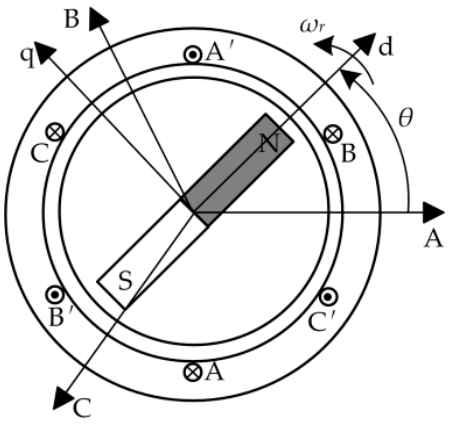
Figure 1. Schematic diagram of permanent magnet synchronous motor (PMSM).